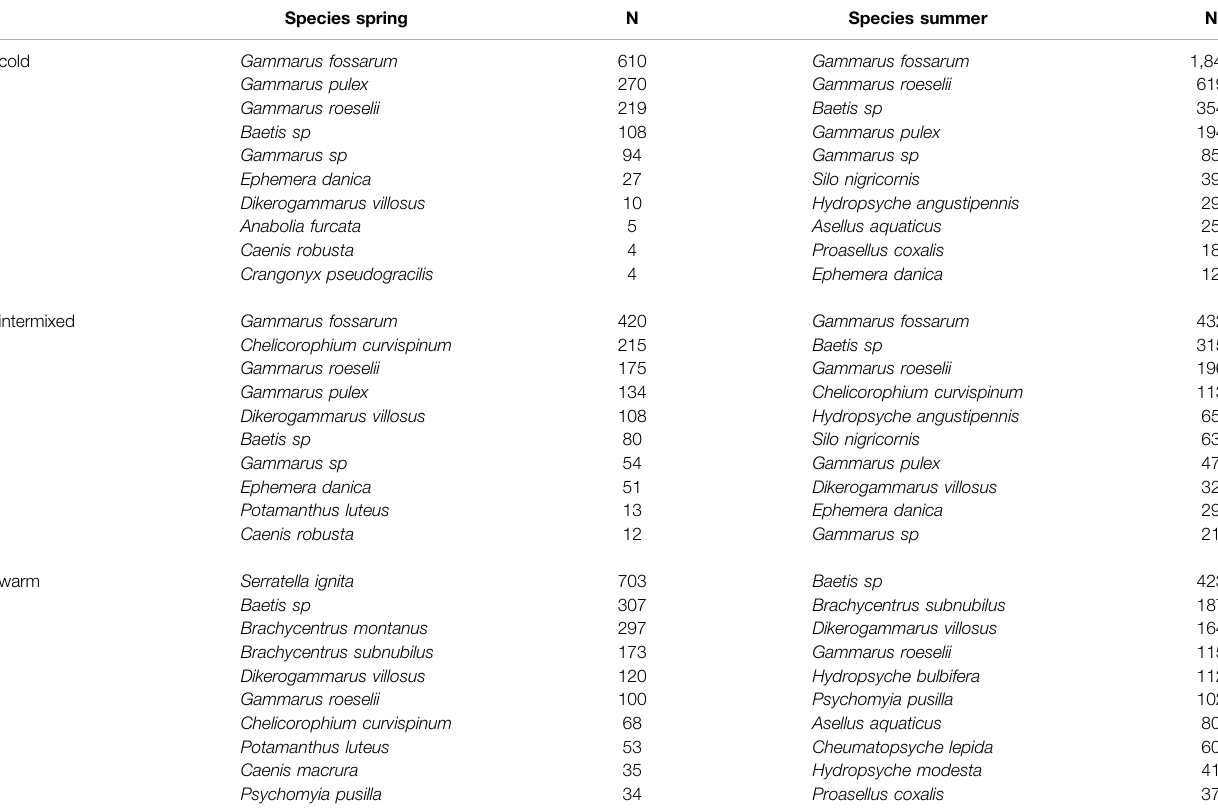
TABLE 3 | Most abundant Species determined by thermal region (TR), and season spring and summer. N = number of detected